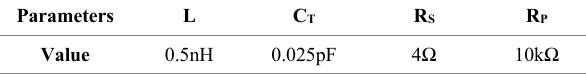
TABLE II. Parameters of PIN MA4AGBLP912 diode Parameters L